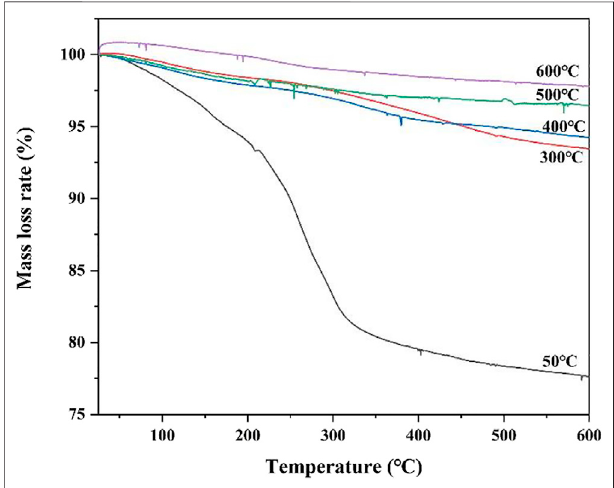
FIGURE 10 | Mass loss curve of C1 cement paste cured at different